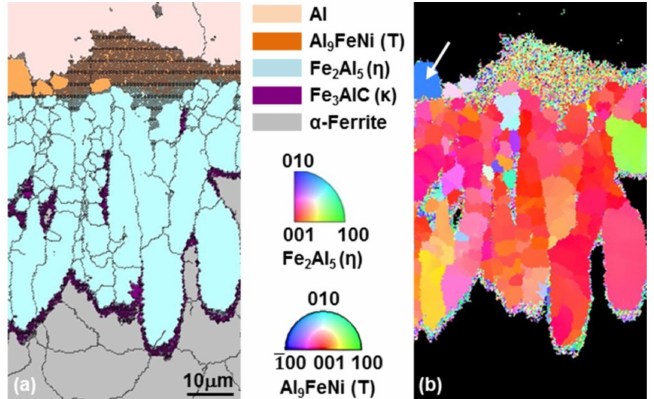
Figure 13. ( a ) EBSD phase map and ( b ) IPF analysis (Al 9 FeNi (T), Fe 2 Al 5 ( η ) and Fe 3 AlC ( κ ) phases) of the specimen hot-dipped for 120